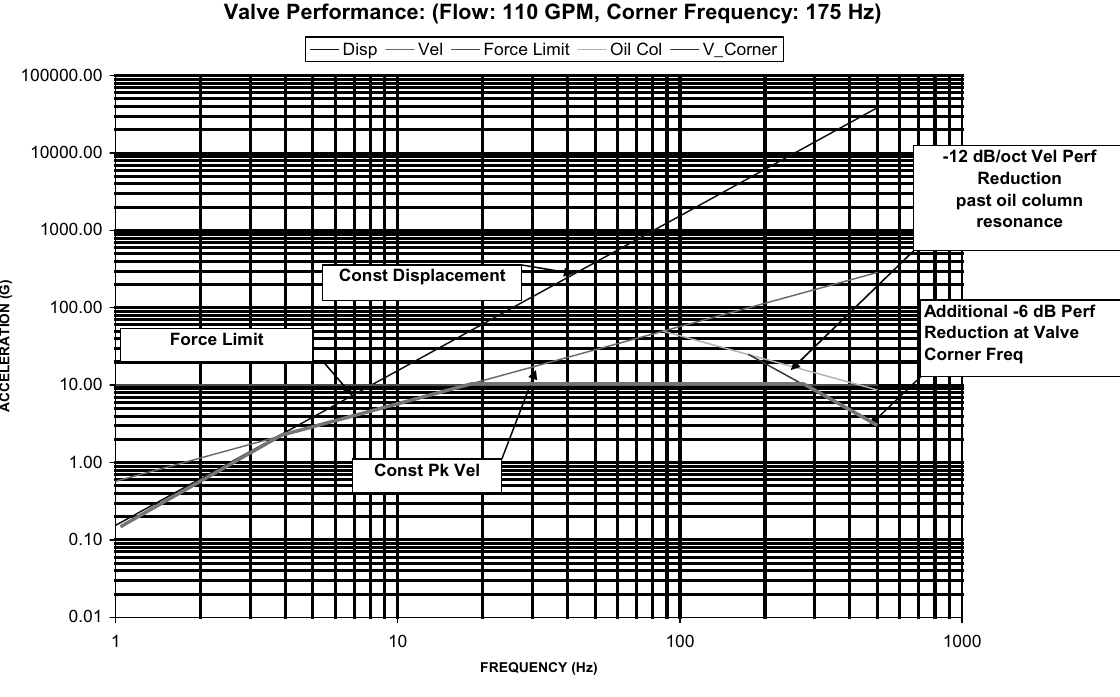
Fig. 2. Dual actuator performance